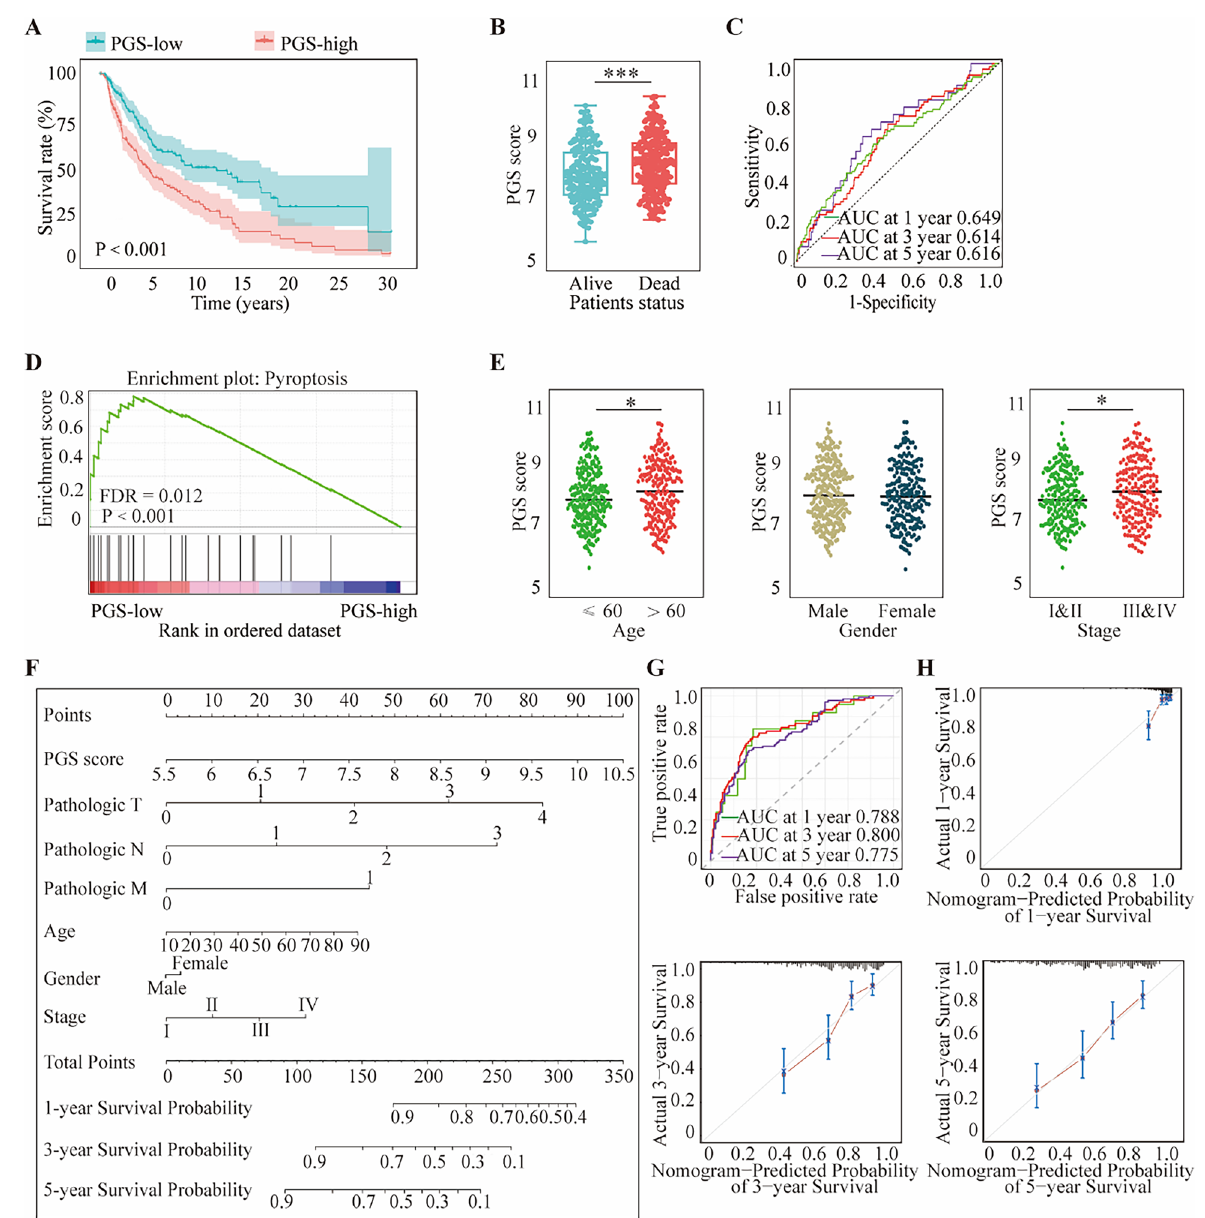
Figure 4. Verification of the PGS scoring system in the TCGA cohort. ( A ) Kaplan–Meier OS curves for patients in the PGS-low and -high groups. ( B ) Comparison of the PGS scores in the melanoma patients. ( C ) Time- dependent ROC curves at 1, 3 and 5 years. ( D ) GSEA evaluation of the pyroptosis pathway in the PGS-low and -high groups. ( E ) Correlation of PGS score with clinicopathological characteristics. ( F ) Nomogram constructed according to the PGS scores and clinicopathological characteristics. ( G ) Time-dependent ROC curves at 1, 3 and 5 years. ( H ) Calibration plot of the contrast between the actual 1, 3 and 5-year and nomogram-predicted OS outcomes. Statistical analysis: * p < 0.05, *** p < 0.001. This figure was created using R software version 4.0.3 (https:// www.r- proje ct. org/) and GSEA software 4.2.1 (https:// www. gsea- msigdb. org/ gsea/ index.